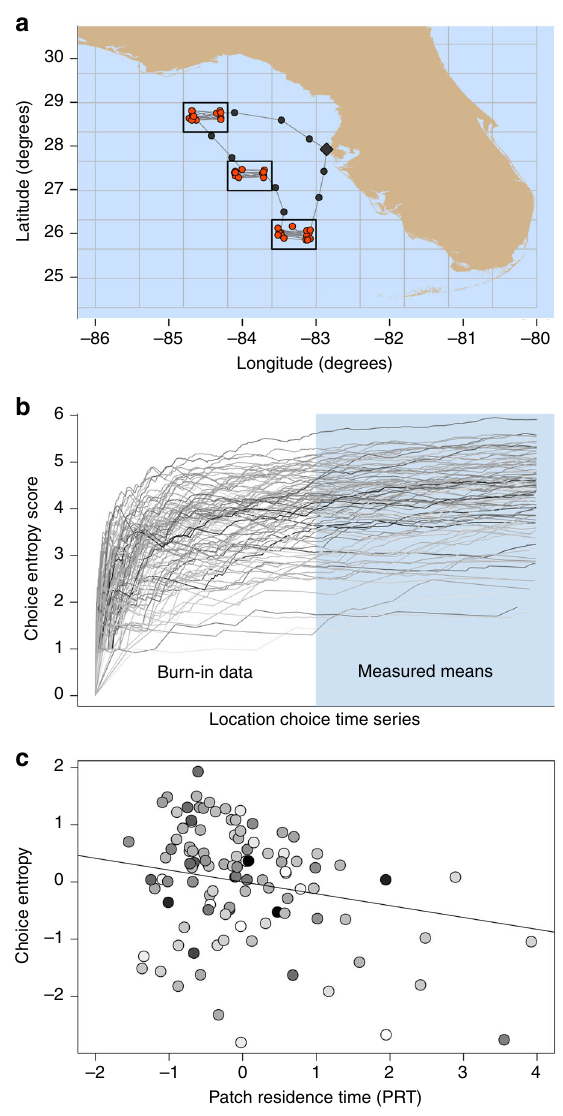
Fig. 2 Quantifying exploration in vessel movement tracks. a The Vessel Monitoring System records hourly positions (pings) of commercial fi shing vessels in the Gulf of Mexico. In the simulated vessel track shown, markers represent pings that have been classi fi ed into one of three activities: fi shing (red circles), transiting ( ● ) or in port ( ◆ ) using a supervised learning algorithm trained using data from trips when on-board fi sheries observers were present. To discretize fi shing grounds, a grid is overlaid on the pings and then cells containing fi shing activity are identi fi ed, allowing a portfolio of fi shing locations to be created for each vessel. The location choices of less- exploratory vessels who repeatedly revisit the same locations are easier to predict (lower choice entropy) than those of more-exploratory vessels who regularly sample new locations (higher choice entropy). b Calculated using 2 years of mobility data from before the disturbance, individual choice entropy trajectories approach plateaus for the 106 vessels in our analysis, showing consistent and substantial separation among vessels in exploratory behavior. The fi rst half of each vessel ’ s trajectory is used as a burn-in period, then the mean of the second half is calculated to quantify the vessel ’ s explore-exploit trade-off (EETO) strategy. Vessels with higher choice entropy scores have more-exploratory strategies. c There is a weak negative correlation ( − 0.242; solid line) between choice entropy and patch residence time. Markers show the centred scores for each vessel expressed in standard deviations around zero means. Darker shading indicates higher pre- disturbance